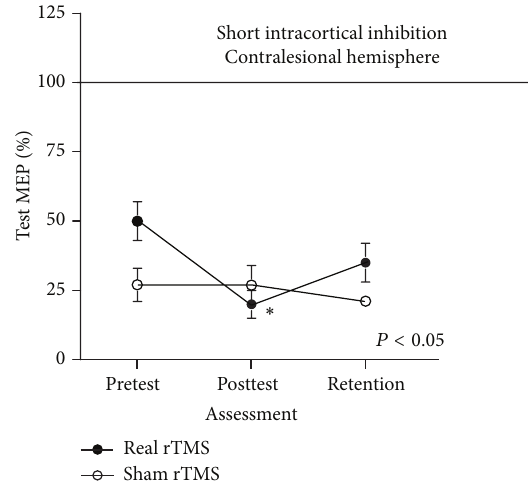
Figure 2: No change in contralesional hemisphere SICI following sham rTMS (open circle) in contrast to increased contralesional SICI (greater inhibition) for the real inhibitory rTMS group. (closed circle). Contralesional hemisphere SICI in the real rTMS group was significantly reduced, suggesting a downregulation of the preintervention hyperexcitable contralesional hemisphere. This downregulation observed in the real rTMS group at posttest was not retained at the 1-month retention